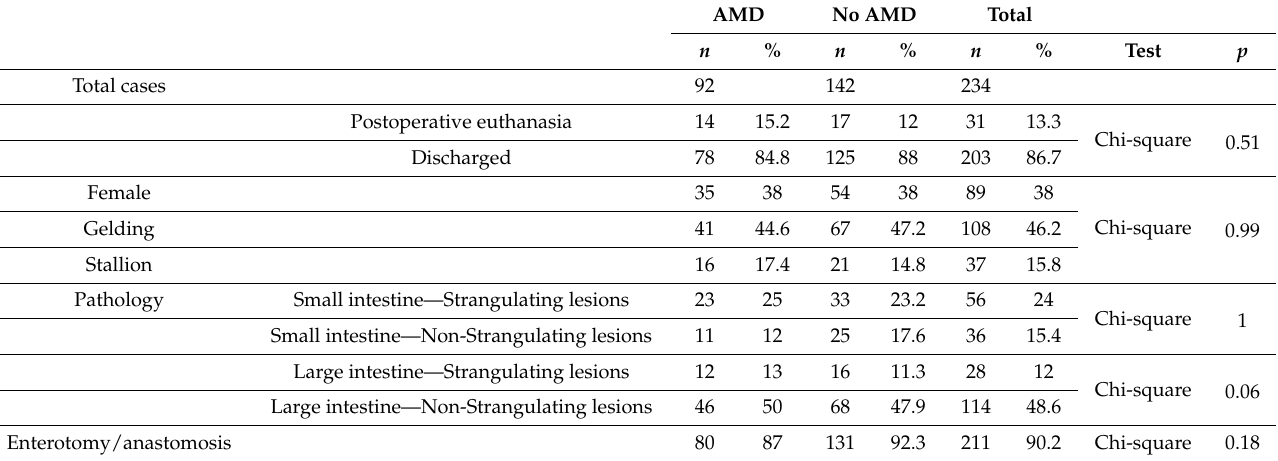
Table 1. Population and surgical data of horses referred for surgical colic between January 2017 and April